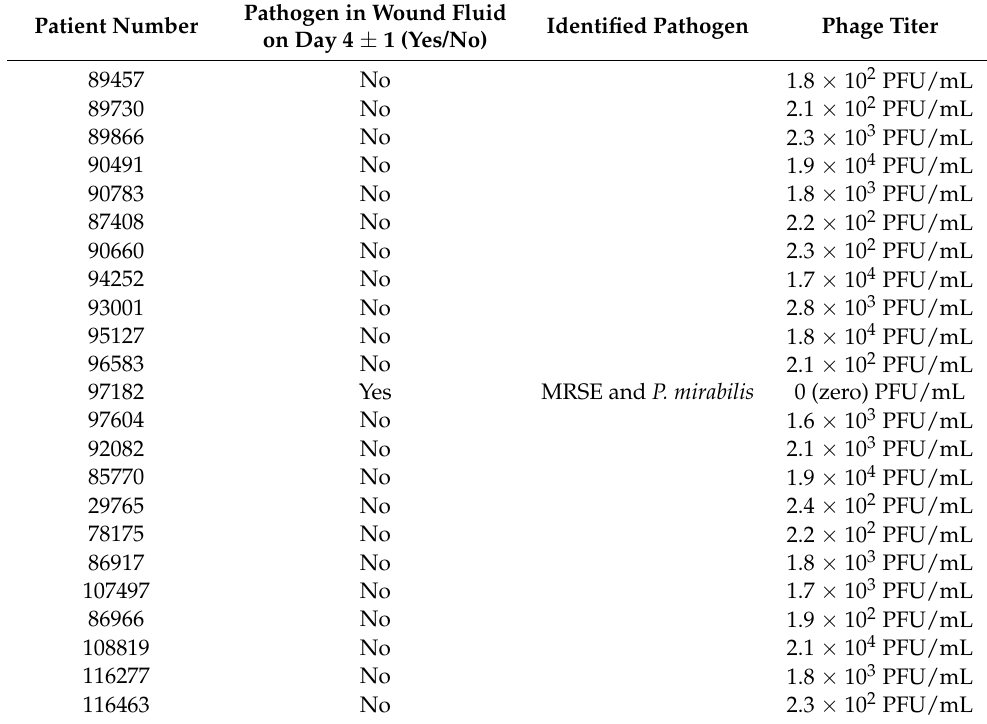
Table 6. Phage titer in the wound fluid obtained from patients of the study group (ITT